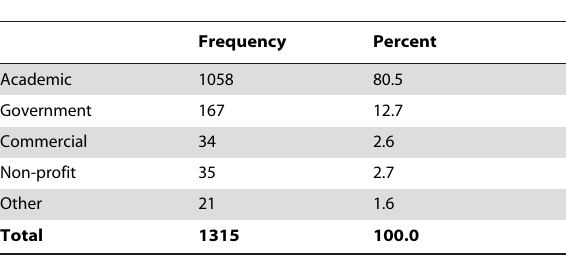
Table 1. Primary work